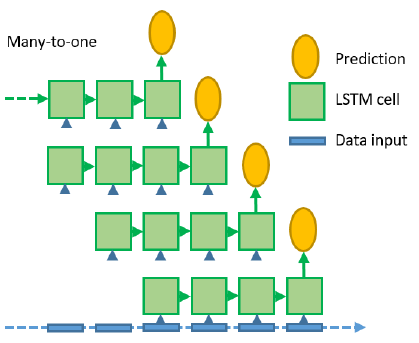
Figure 3. Schematic of the sliding many-to-one implementation of LSTM. (Source: Croonen [18]). A single fully connected layer was used to reduce the final LSTM output to a single prediction value. The model was trained using the ADAM optimiser [34] and using a binary cross-entropy error function. It was trained for 1000 cycles on a single GPU using stochastic mini-batching to reduce the memory